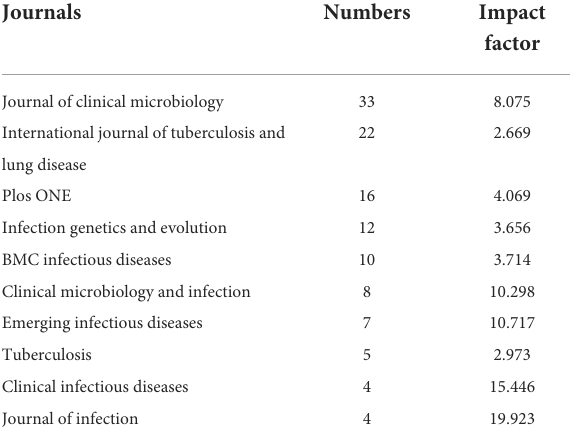
TABLE 1 Productivity and average impact factors (in the past five years) of top 10 active journals.